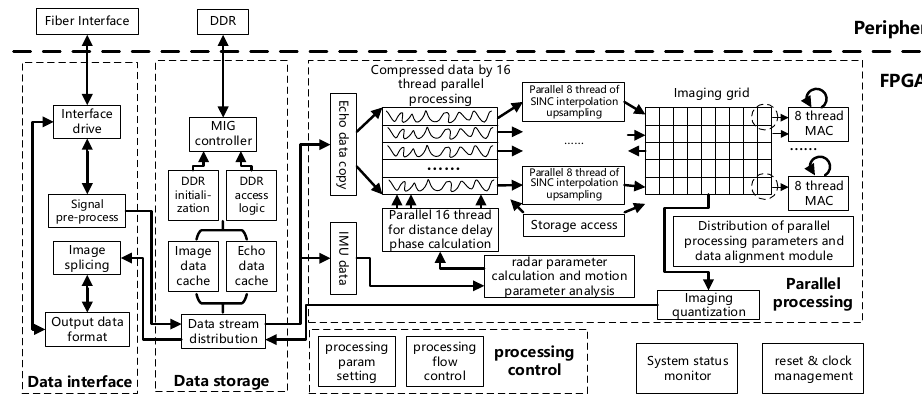
Figure 14. Block diagram of synthetic aperture radar (SAR) real-time imaging system.